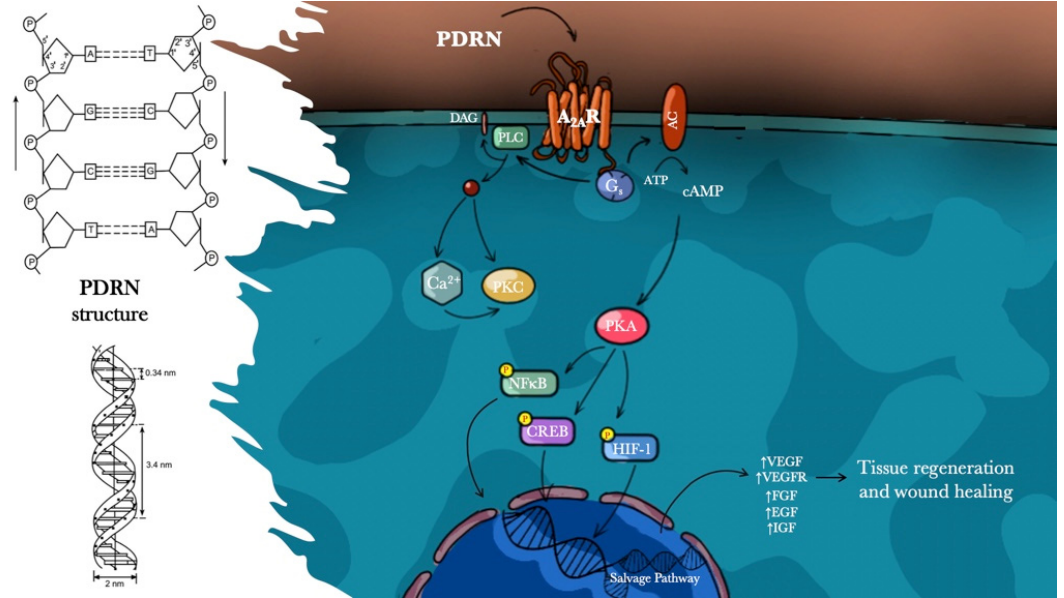
Figure 3. Influence of PDRN on wound healing.